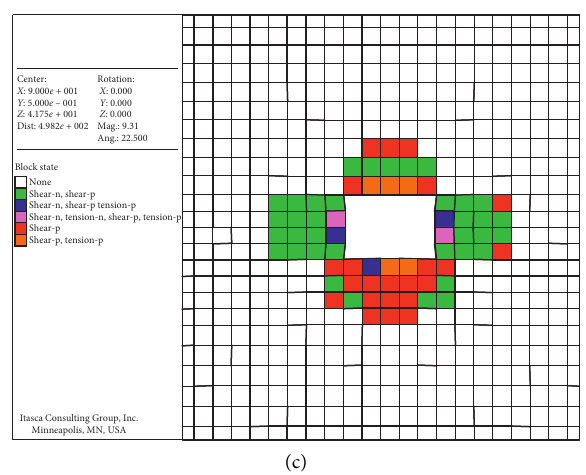
Figure 12: Cloud diagram of the plastic zone. (a) 300 step; (b) 600 step; and (c) 2100 step.